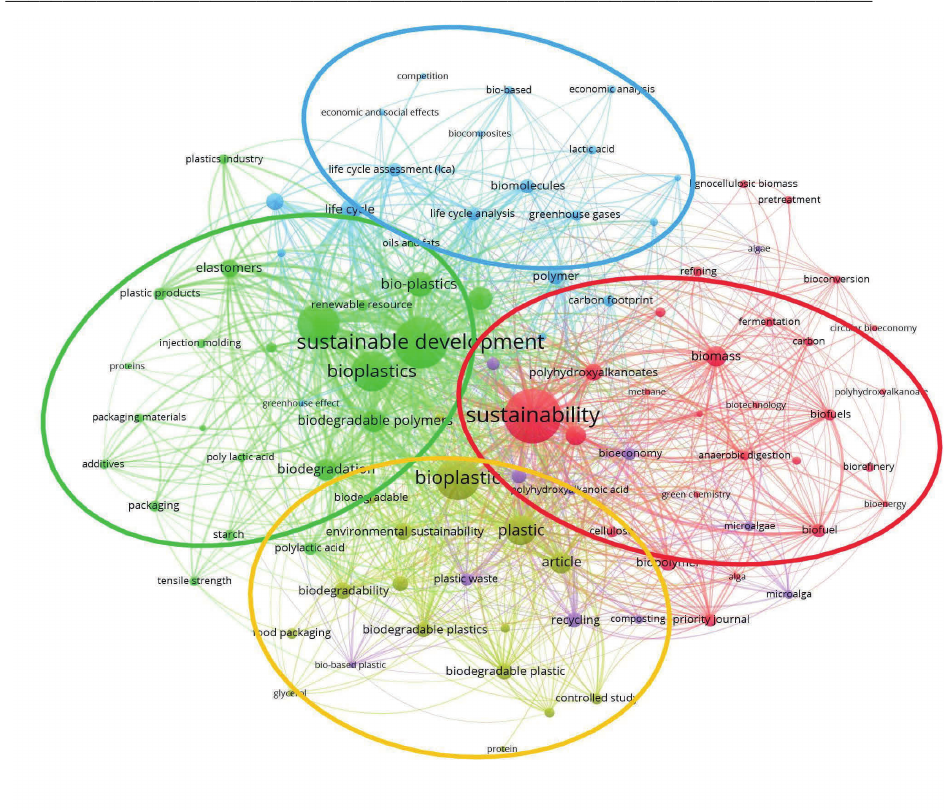
Fig. 5. Visualization of co-occurrences for keywords ‘bioplastic’ and